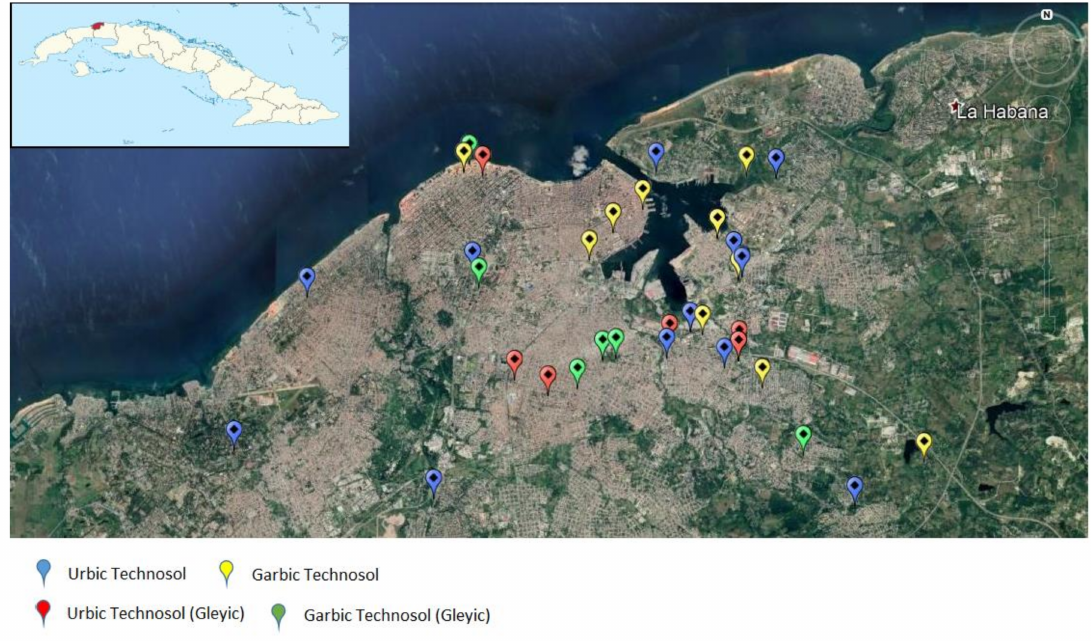
Figure 1. Location of the studied soils in Havana, Cuba (map from Google